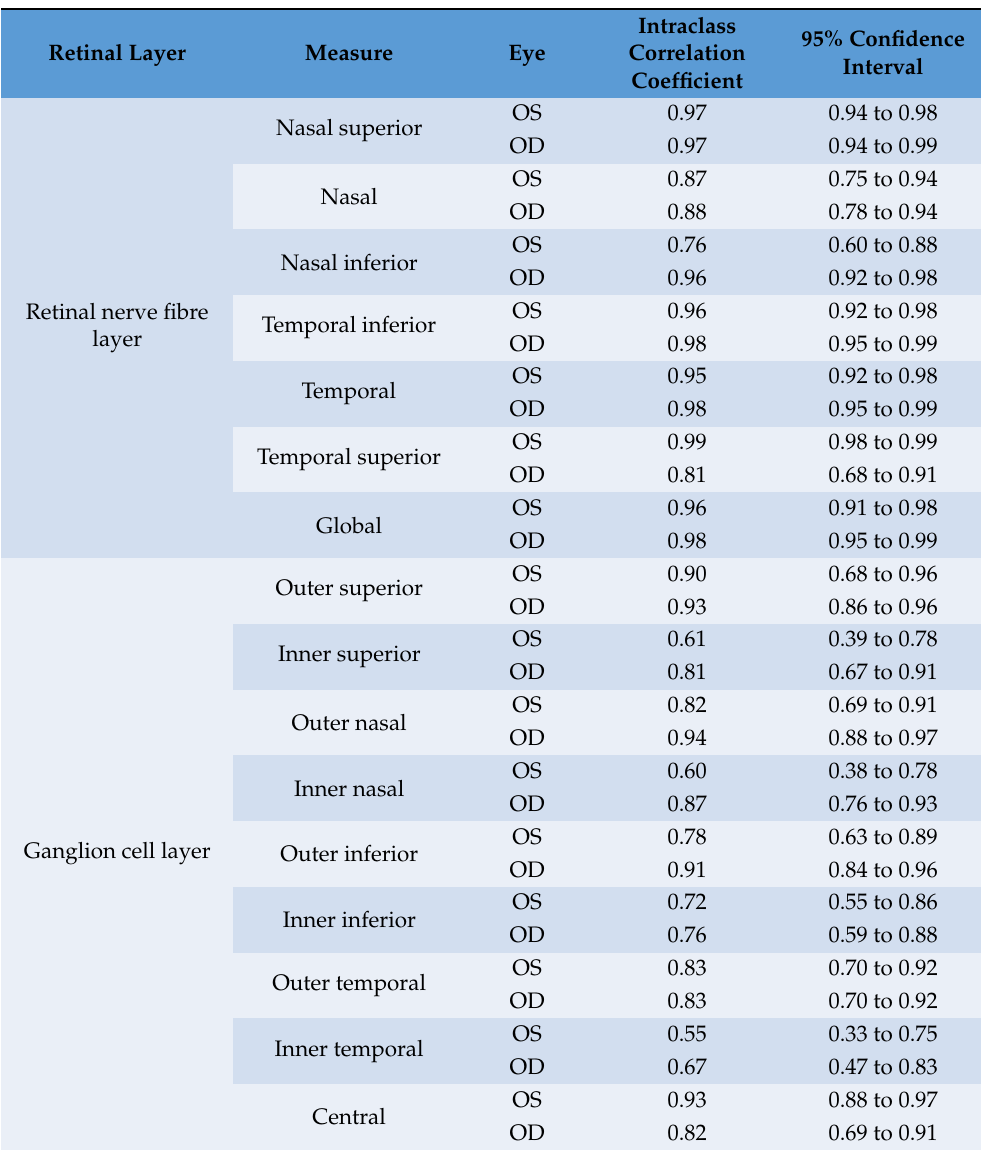
Table 3. The intraclass correlation coefficient of the ganglion cell layer and retinal nerve fibre layer thicknesses, with the corresponding 95% confidence interval. OS: left eye; OD: right eye. Intraclass Retinal Layer Measure Eye